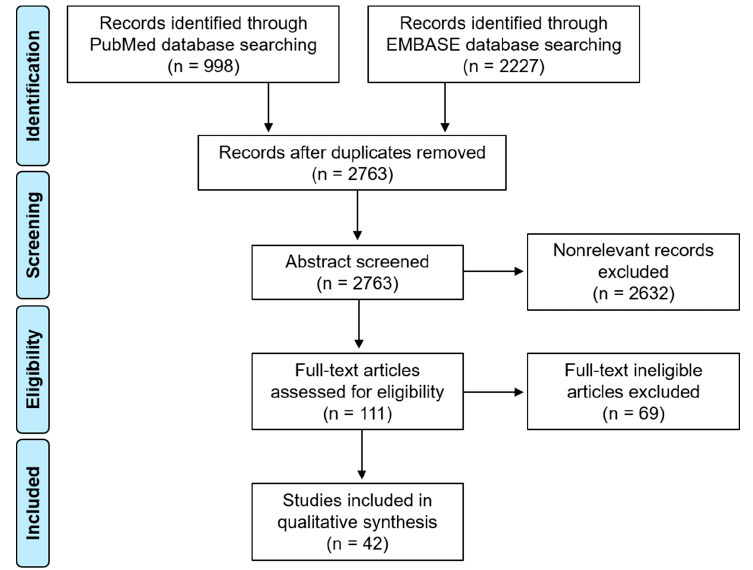
Figure 1. Flow chart for database search.